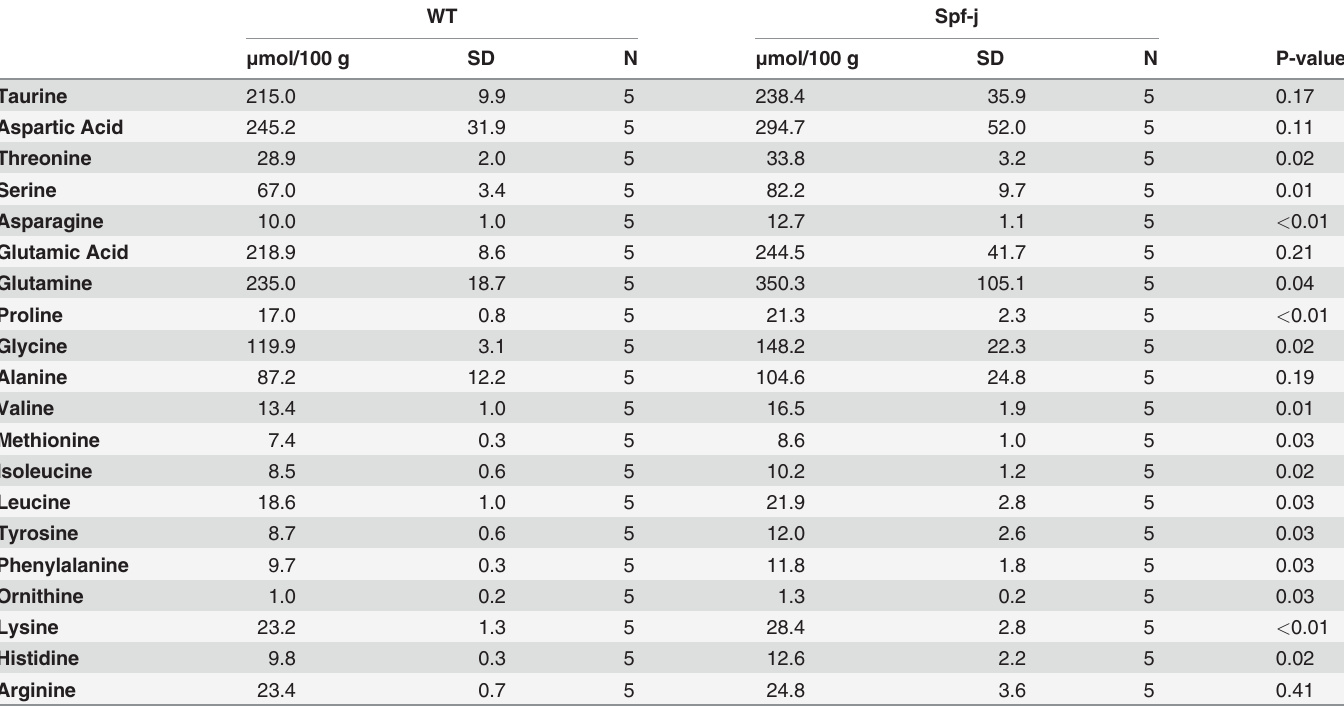
Table 3. Cerebral amino acid concentrations at